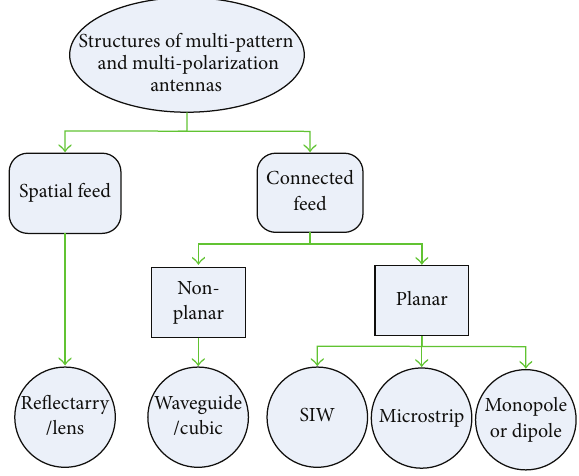
Figure 12: The different structures of multipattern and multipolar- ization